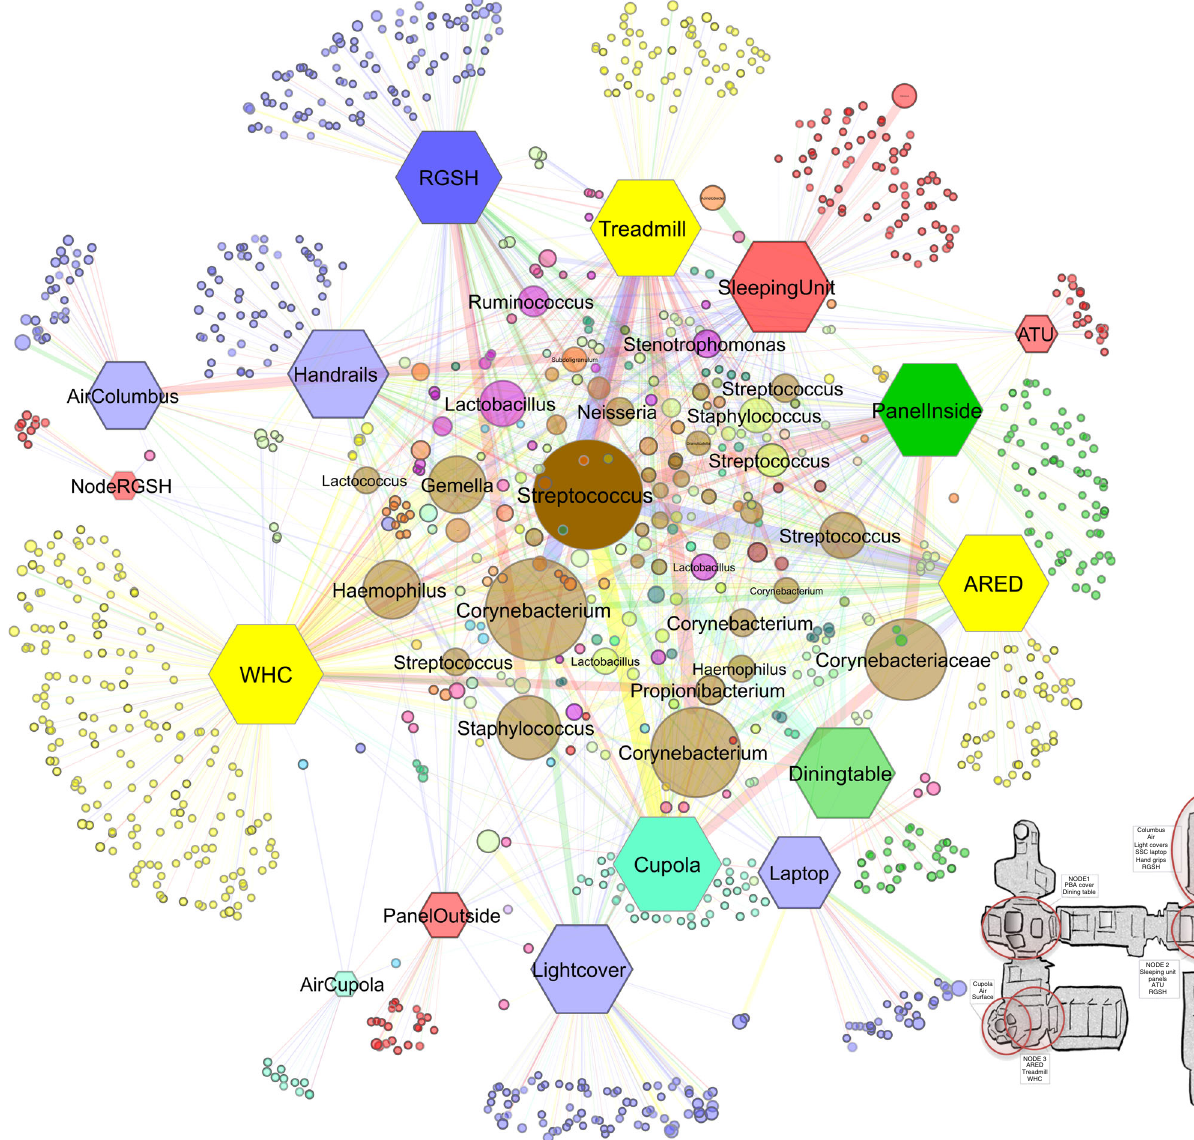
Fig. 2 Network analysis and model of the ISS with sampling sites (indicated by red circles; full information of ISS model is given in Supplementary Fig. 4). Samples are shown as hexagons, RSVs are shown as circles. Colors of sample nodes refer to respective ISS modules. RSV nodes show mixtures of these colors if they were shared by several locations and modules of the ISS. The borders of the circles are darker, when found in several sessions. The size, transparency and the size of the node descriptions corresponds to their abundance. The thickness and transparency of the edges (lines) follows the calculated e-weights. Layout: Spring Embedded, with e-weights. color code: yellow (NODE3), red (NODE2), blue (Columbus), aqua (Cupola), green (NODE1). Abbreviations: WHC (Waste and Hygiene Compartment), ARED (Advanced Resistive Exercise Device), ATU (Audio Terminal Unit), RGSH (Return Grid Sensor Housing). A close-up model of the ISS is shown in Supplementary Fig.